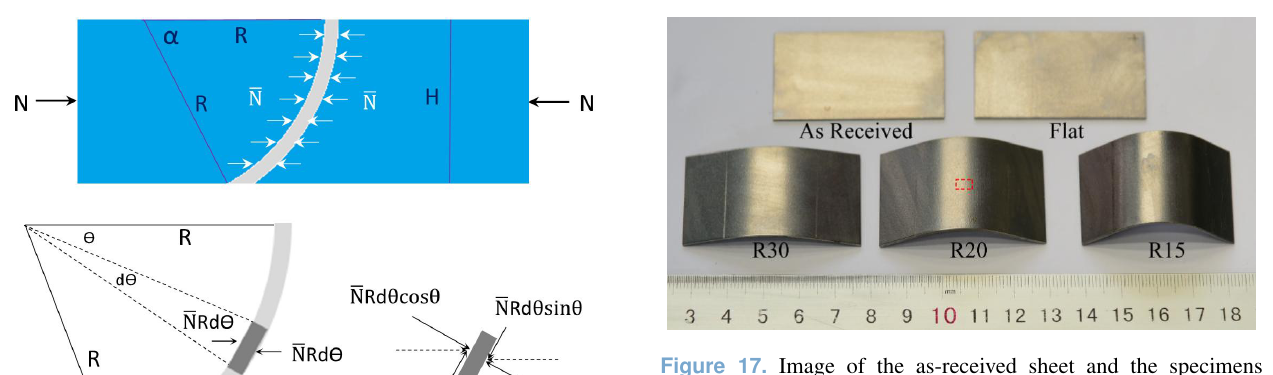
Figure 17. Image of the as-received sheet and the specimens stamped by flat and curved dies (R30, R20,